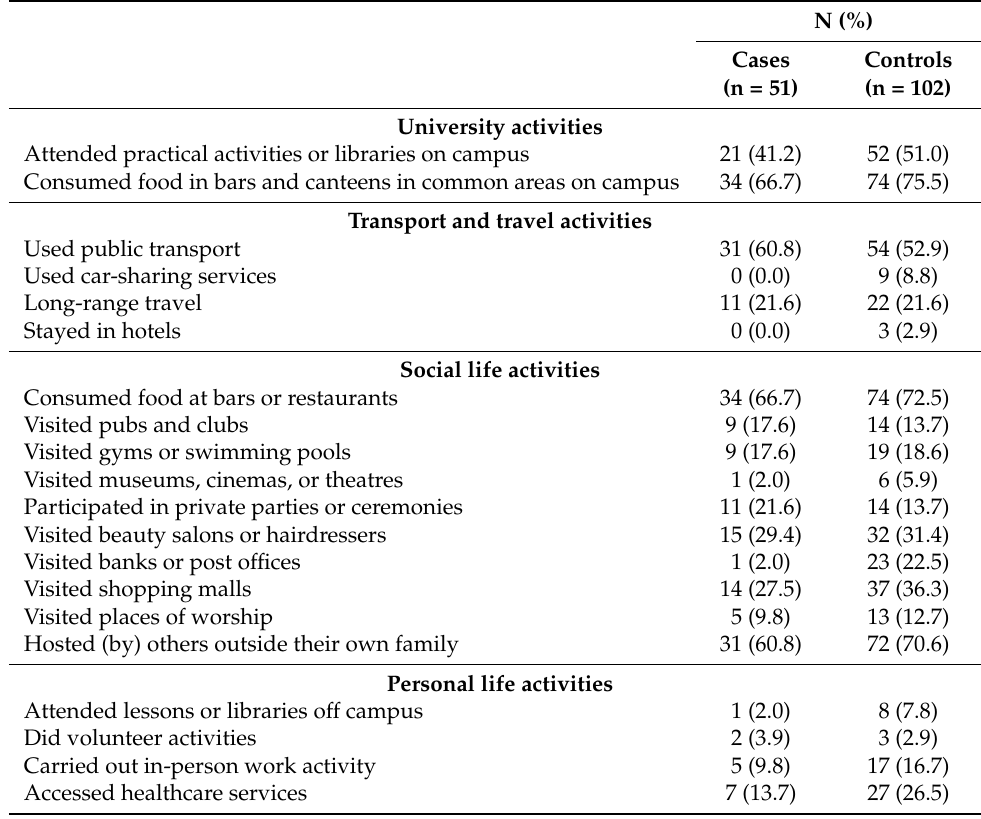
Table 2. Activities during the enquiry period of cases and matched-control students attending the Sapienza University of Rome between October 2020 and July 2021. Results are expressed as frequency